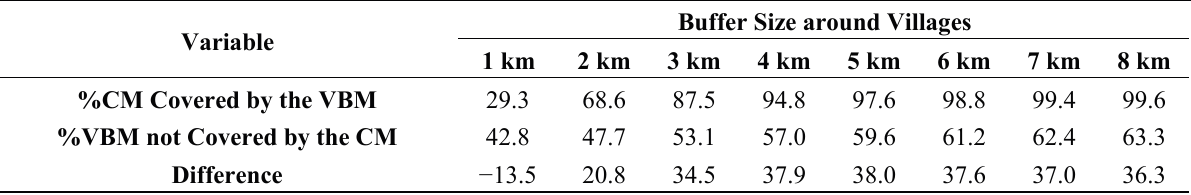
Table 2. Overlaps and no-overlaps between the crop mask and village buffers mask for buffer sizes between 1 km and 8